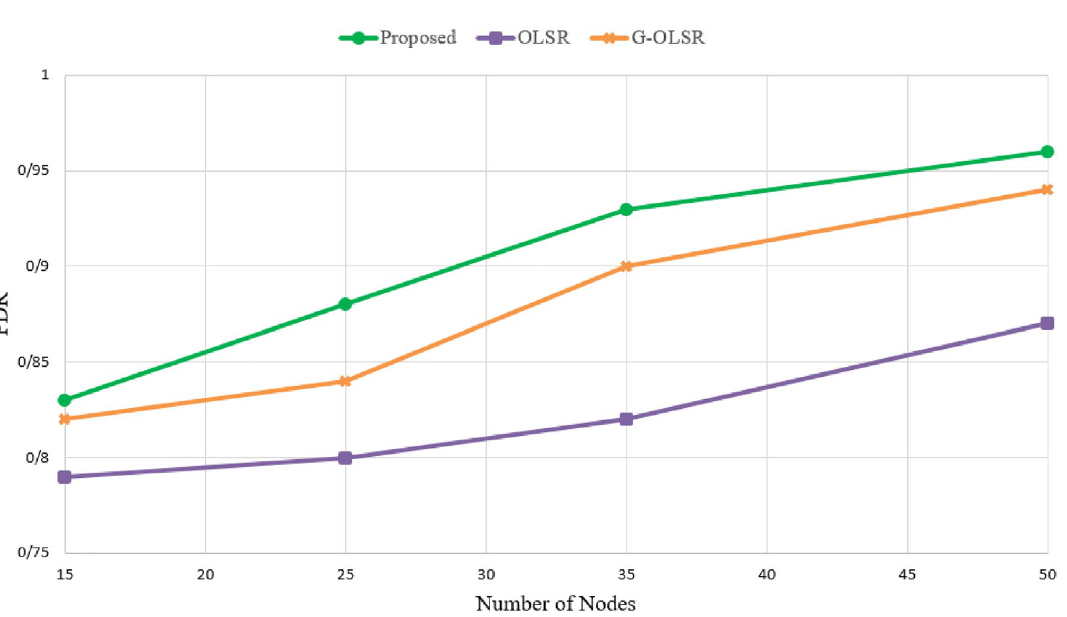
Figure 10. Comparison of different routing methods in terms of